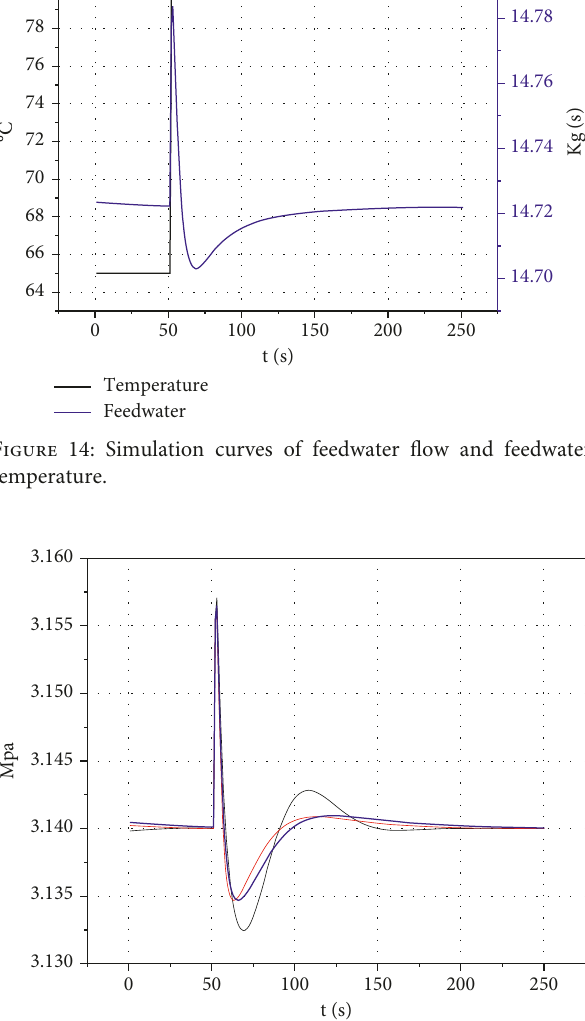
Table 7: Performance indicators of the three algorithms when set point steps up from 3.14 MPa to